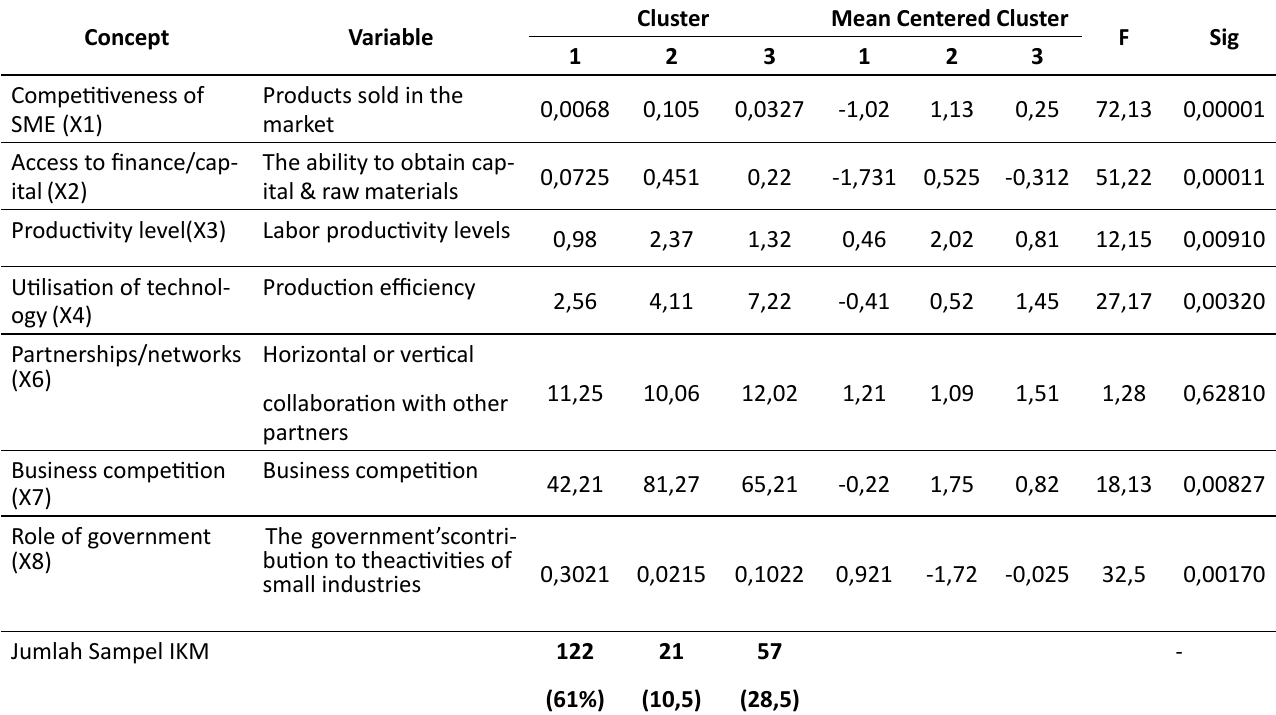
Table 2: SME Grouping in East